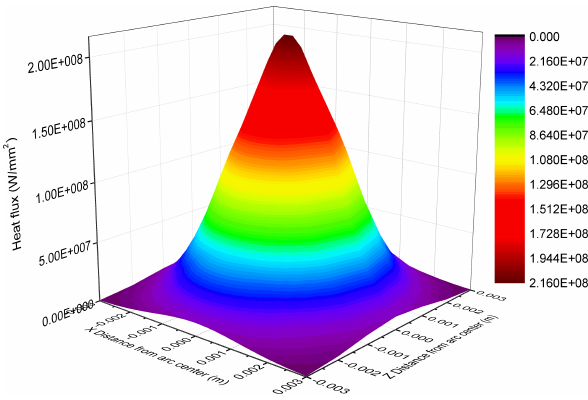
Figure 1: Gaussian surface heat flux distribution of welding